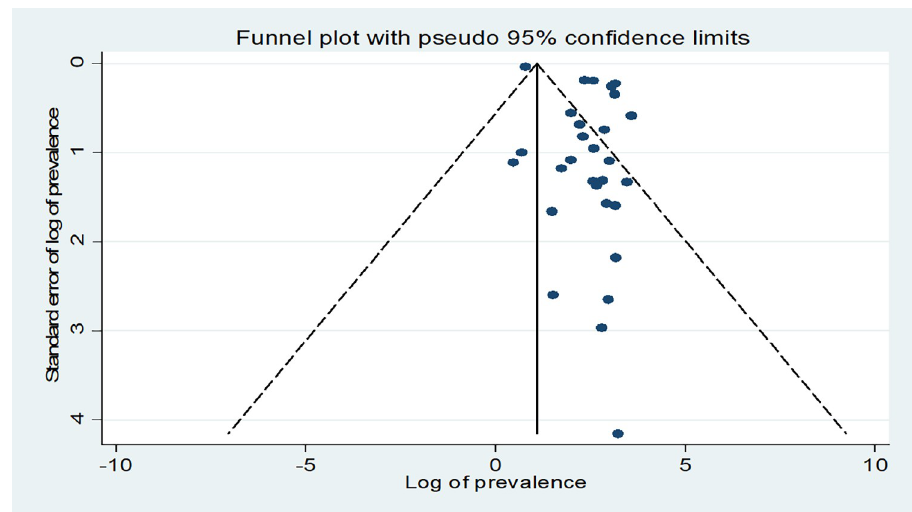
Fig 2. Funnel plot of the meta-analysis used to show a visual description of publication bias.